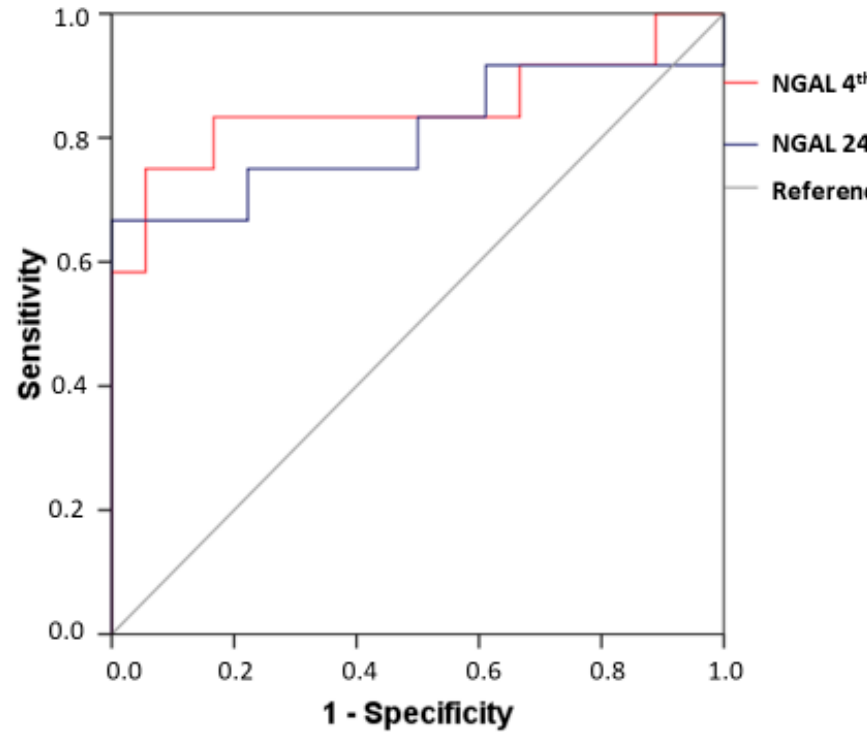
Figure 4. ROC curves for the diagnostic ability of plasma NGAL, measured at the 4th and 24th hour after the angiographic examination in the CI-AKI group.